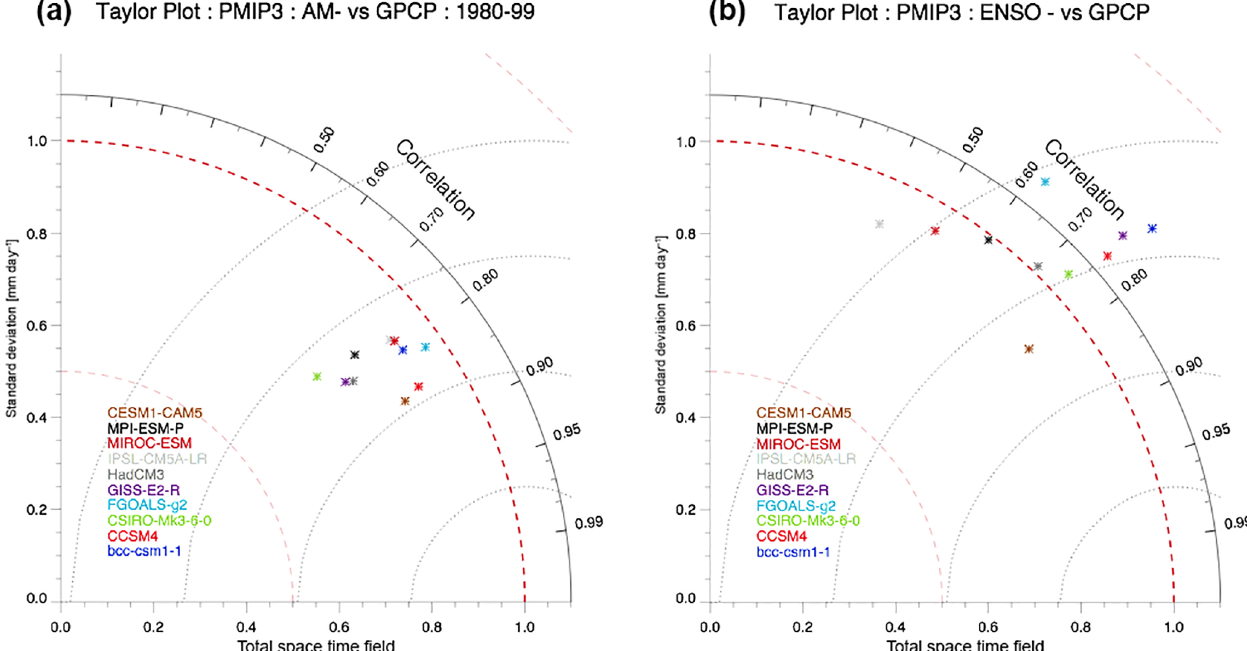
Figure 5. Taylor diagrams of global precipitation over land (a) and ENSO (as defined by the Nino3.4 index) correlations to precipitation over land (b) . Each panel shows models that completed PMIP3 simulations of the last millennium compared to precipitation observations from GPCP for the overlapping periods of 1980–1999 (a) 1980–2014 for (b) (not all models simulated the full period, but all are at least